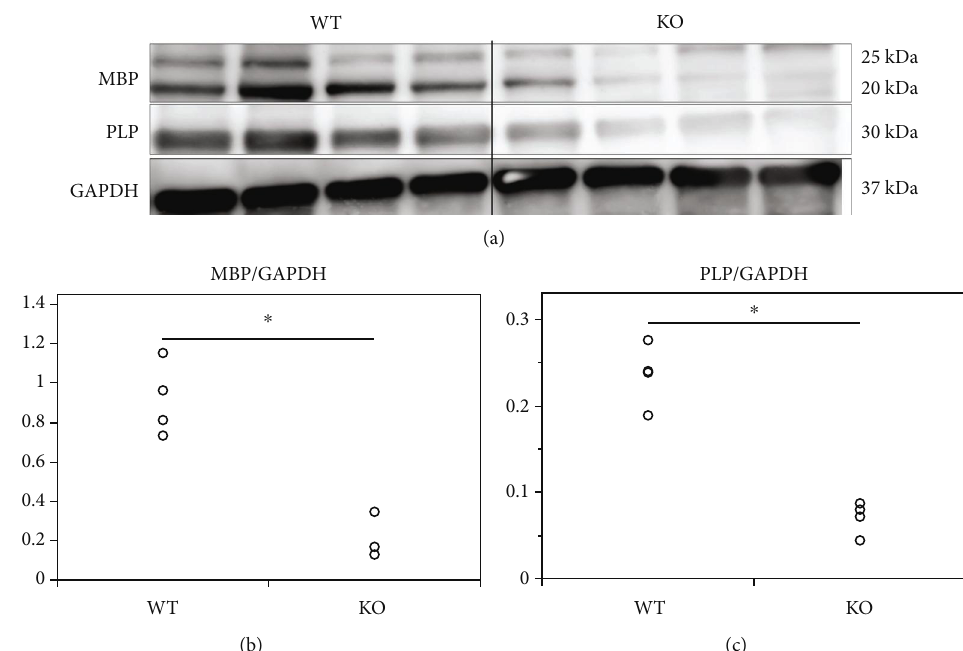
Figure 6: Expression of MBP and PLP in the spinal cord of 10-week-old mice. Wild-type (WT) and miR-23-27-24 cluster knockout (KO), n = 4 per group. (a) Representative western blots of MBP, PLP, and GAPDH proteins. (b) MBP expression in KO mice was signi fi cantly lower than that in WT mice, ∗ p < 0 : 05 . (c) PLP expression in KO mice was signi fi cantly lower than that in WT